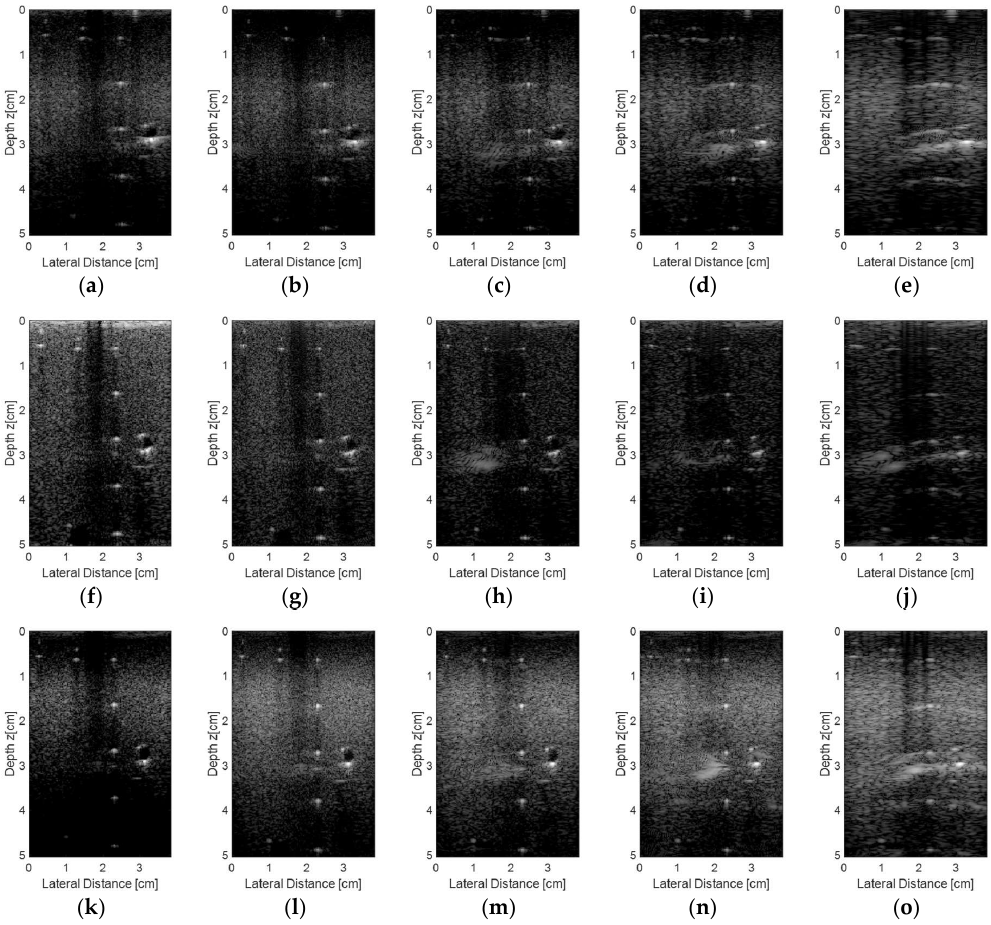
Figure 13. Images obtained from the commercial phantom using plane waves with seven angles and three angles steps: 0.5° ( a – e ), 1.0° ( f – j ), and 1.5° ( k – o ). The images were processed with the Verasonics VDAS method ( a , f , k ) and with the proposed method with all 128 elements ( b , g , l ), 65 elements ( c , h , m ), 44 elements ( d , i,n ) and 23 elements ( e , j , o ) receiving the data.